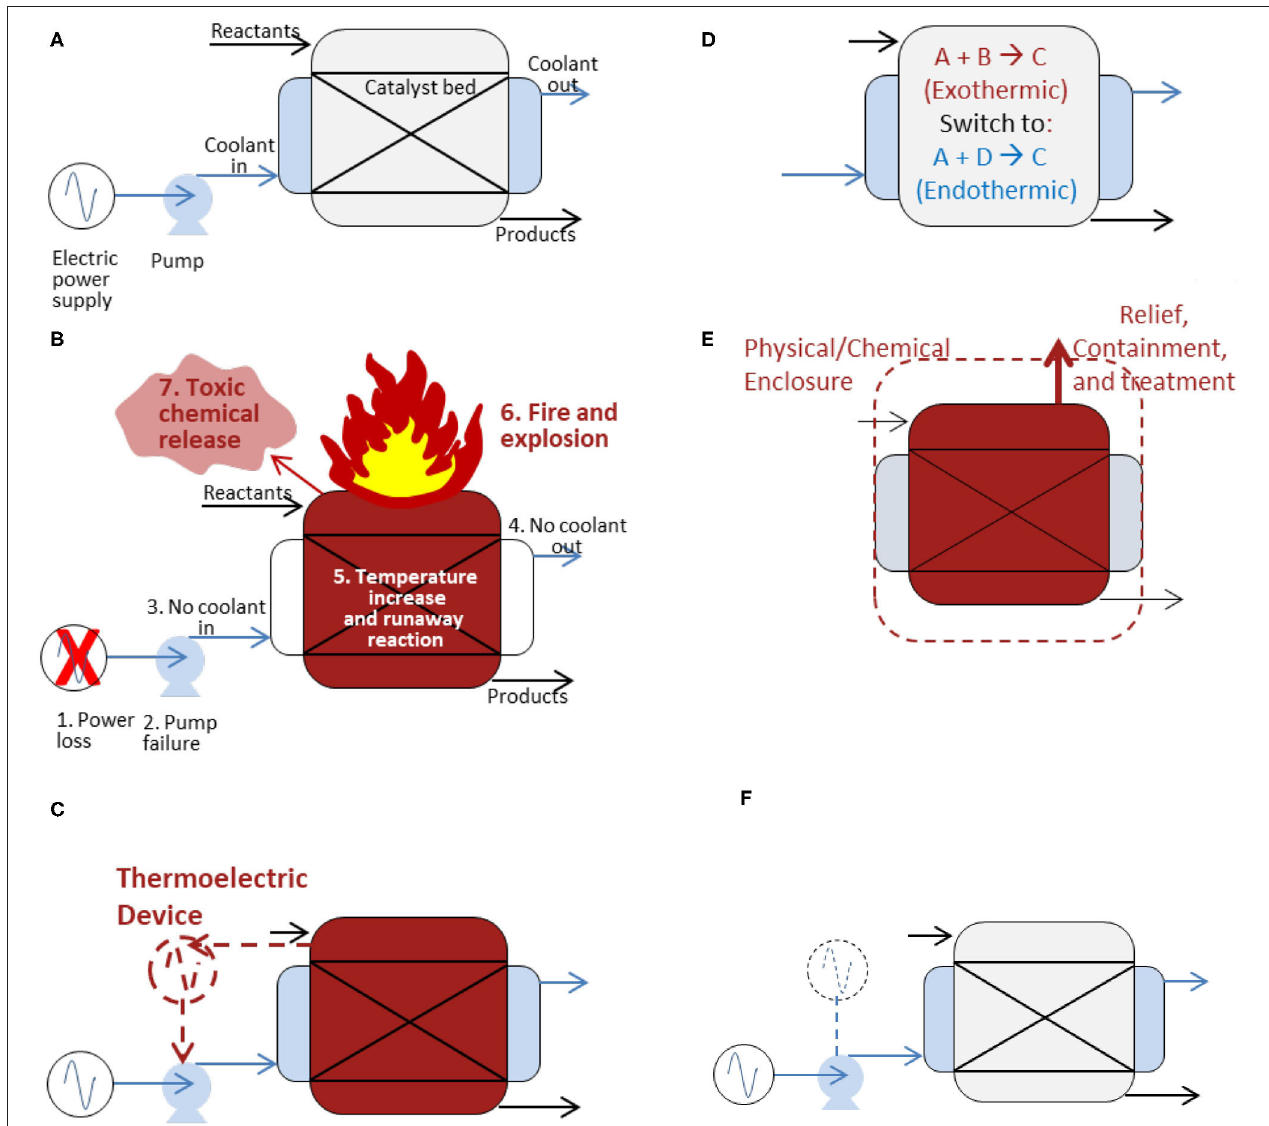
FIGURE 2 | (A) An exothermic reaction system during normal operation. (B) Non-resilient operation following power loss. (C) Fail-safe via substitution to resilient emergency power. (D) Fail-safe via reactant substitution. (E) Fail-safe via containment, relief, and treatment. (F) Redundancy via an energy storage and dispatch